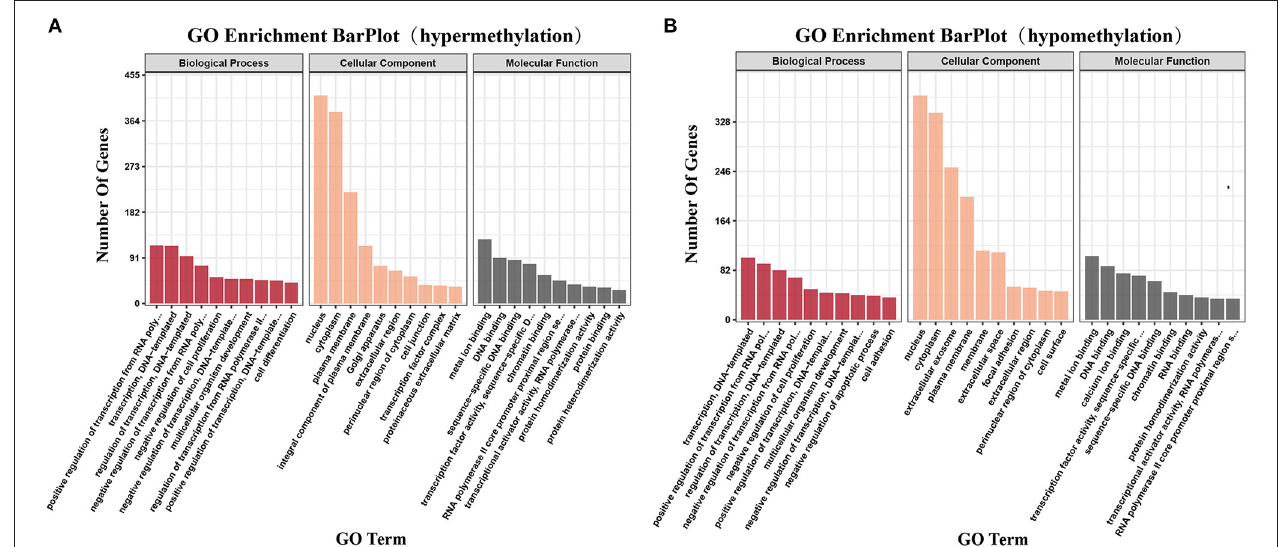
FIGURE 6 | Gene ontology and pathway analysis of differentially methylated genes. (A) The significant gene ontology (GO) categories of hypermethylated DMRs in ALV-J-positive chickens as compared with ALV-J-negative chickens ( P ≤ 0.05); (B) the significant GO categories of hypomethylated DMRs in ALV-J-positive chickens as compared with ALV-J-negative chickens ( P ≤ 0.05).